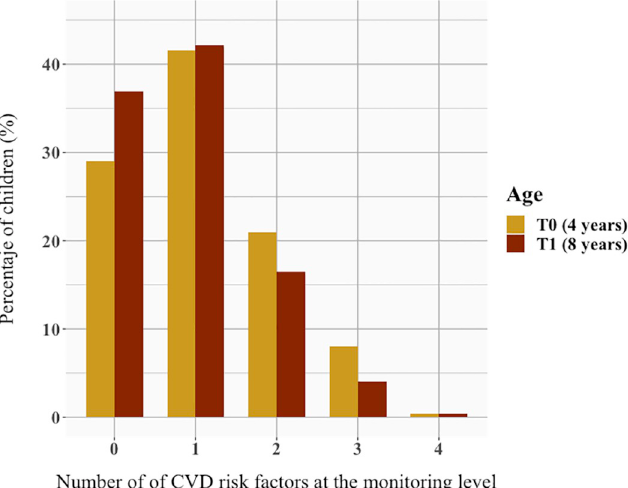
Fig 2. Distribution of the number CVD of risk factors at the monitoring level in the study population.